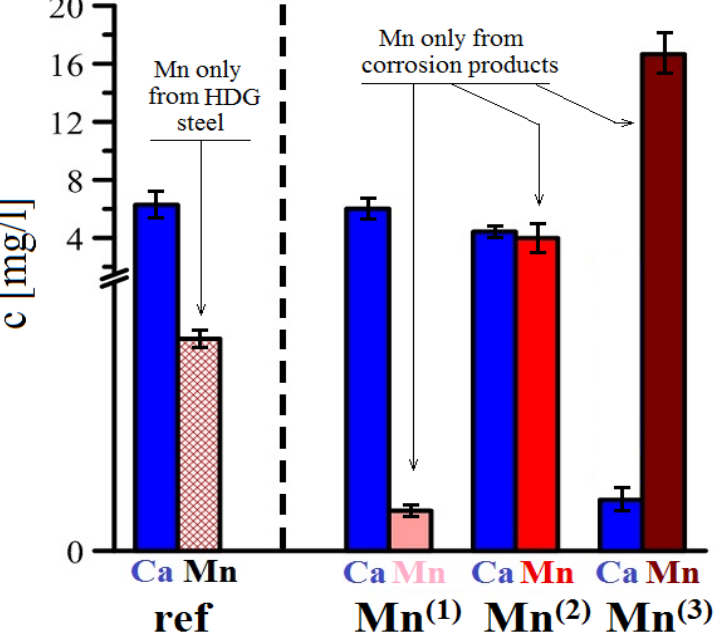
Figure 32. Resulst of AAS analysis comparing the content of Ca/Mn in corrosion products after pick- ling in HCl. pickling in